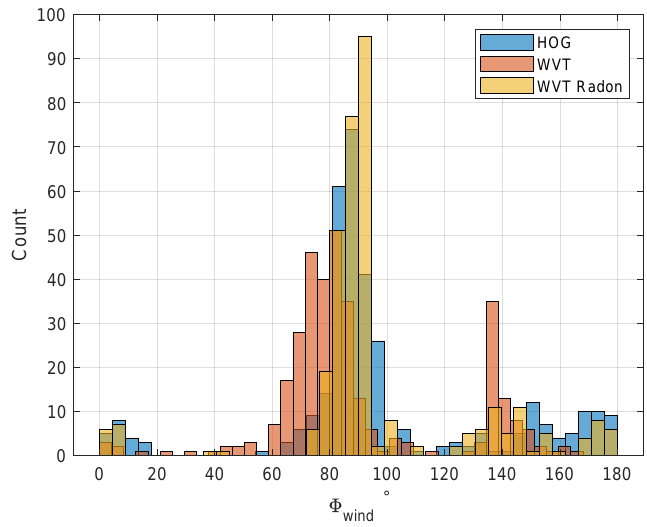
Figure 14. Histogram of estimated directions for 5 km cells.